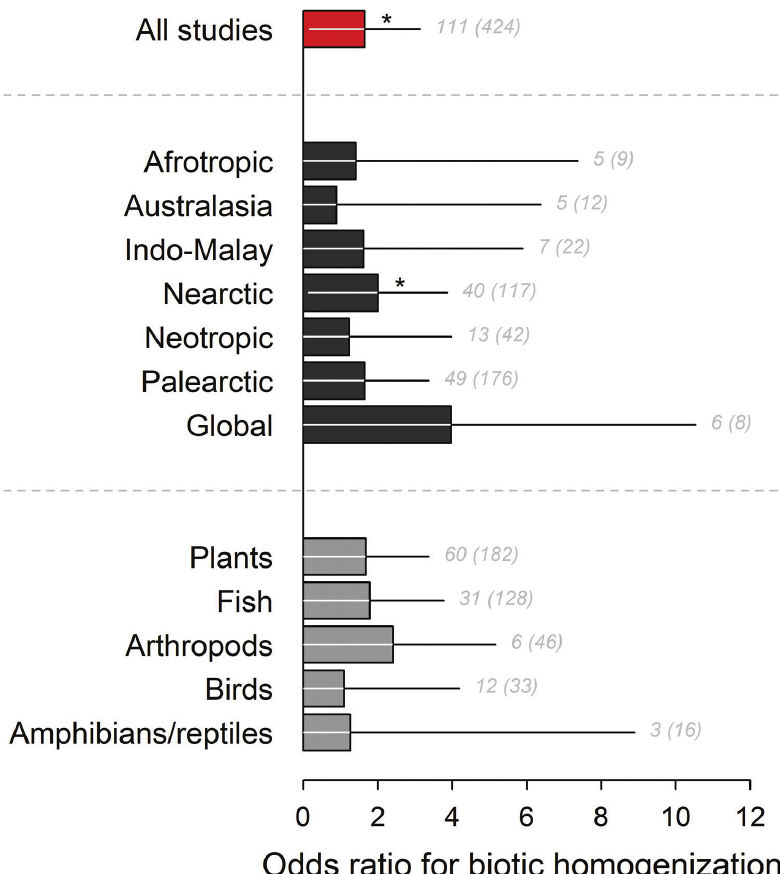
Figure 2. Estimated odds ratio and associated 95 % confidence intervals for the demonstration of biotic homogenisation across all studies assessed (top) and studies organised by biogeographic areas (middle) and taxonomic group (bottom). Asterisks indicate statistically significant effects (p<0.05). Odds ratios were estimated from generalised linear mixed effect models using a binomial error structure where studies were coded 1 if they reported biotic homogenisation or 0 if they reported no significant change or biotic differentiation. Additionally, potential variations due to methodological factors were accounted for by specifying article identity , spatial grain , spatial extent , facet , temporal extent and metric as random effects in the models. Numbers in grey indicate the number of published articles for each group included in the models. Groups in middle and bottom panels represented by less than two articles were excluded from the